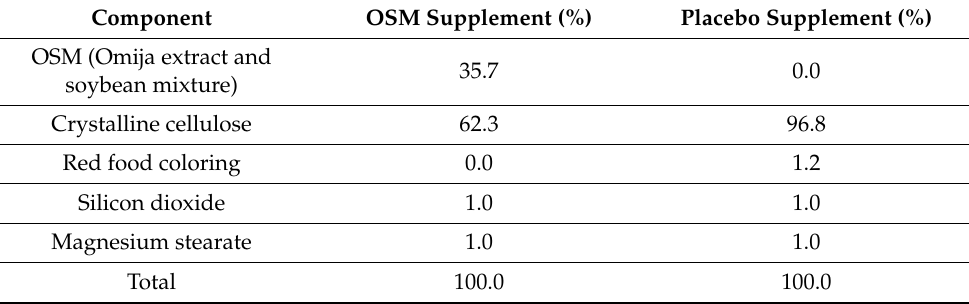
Table 1. Composition of the